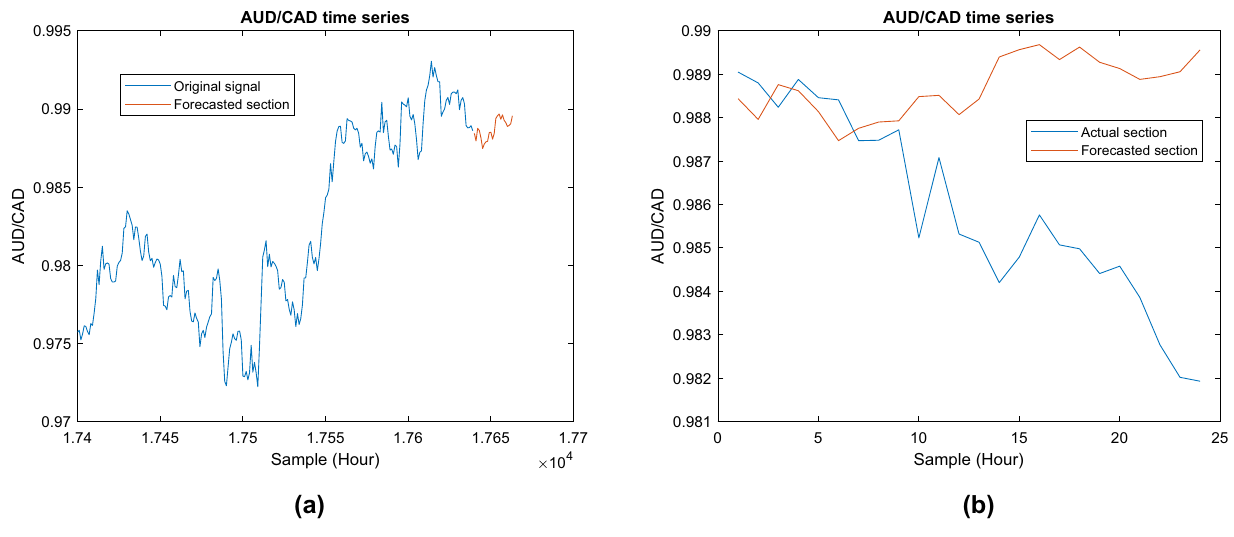
Fig. 7 a Forecasting the upcoming 24 data samples of the AUD/CAD exchange rate using the apriori 120 data samples. b Comparison of the forecasted data [24 samples (hours)] with the actual data. There is negligible forecasting accuracy with a correlation coefficient of 0.08